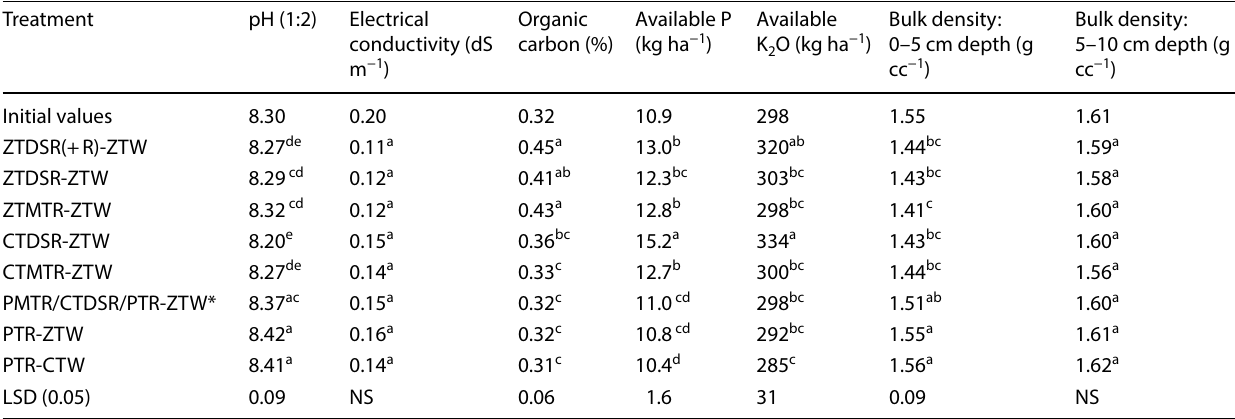
Table 1 Effect of different crop establishment methods on soil properties after seven years recorded after wheat harvest in rice–wheat sys- tem